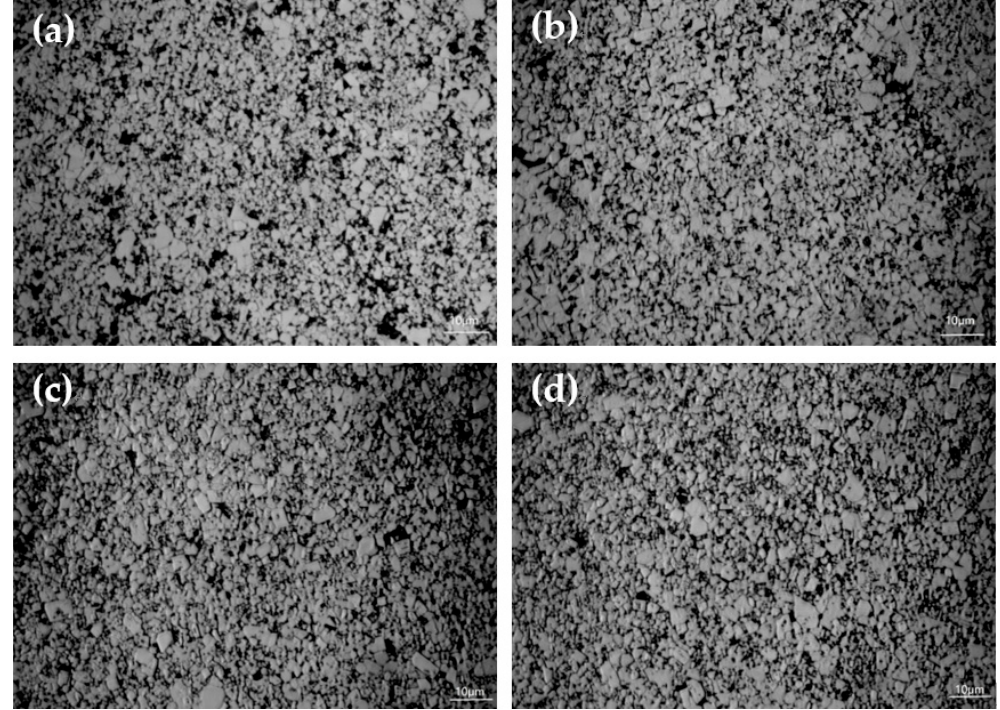
Figure 6. ( a ) Metallographic of Group 1; ( b ) metallographic of Group 2; ( c ) metallographic of Group 3; ( d ) metallographic of Group 4.